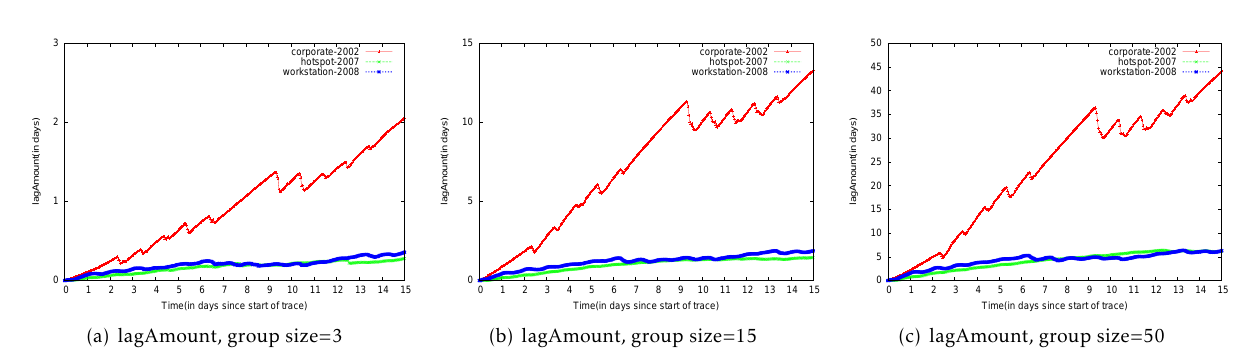
Figure 12. Best performance achievable for the various